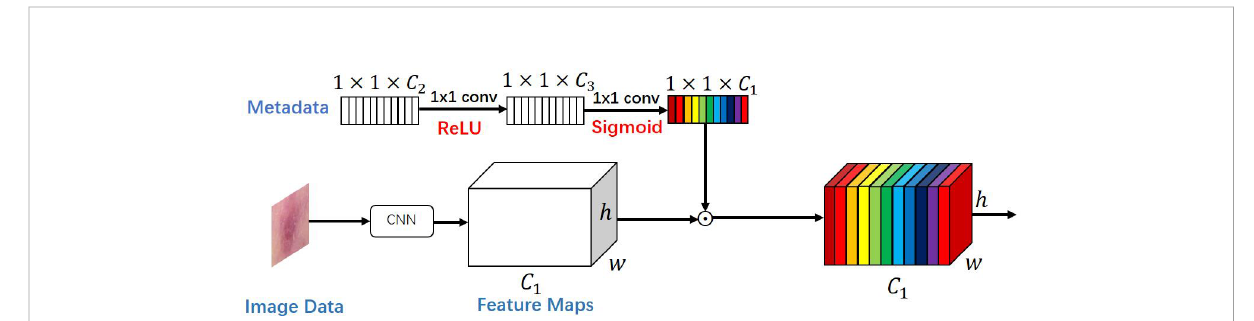
FIGURE 2 The proposed multiplication-based data fusion can make the metadata directly control the importance of each feature channel, helping the network focus on more discriminative